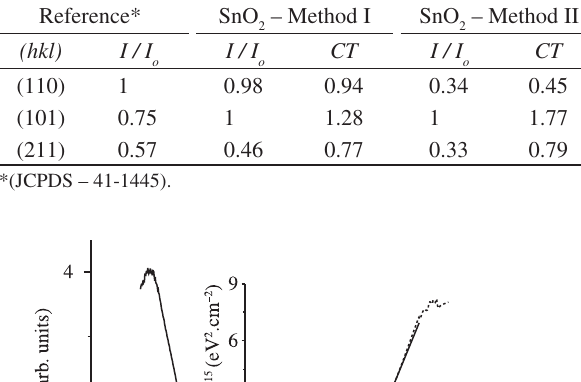
Table 2. Texture coefficients ( CT ) for SnO